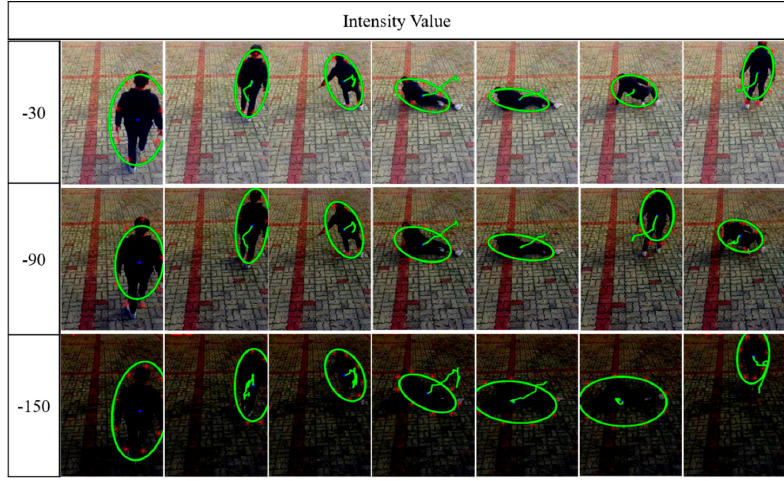
Figure 20. Tracking results with the synthetic testing images for illumination changes.